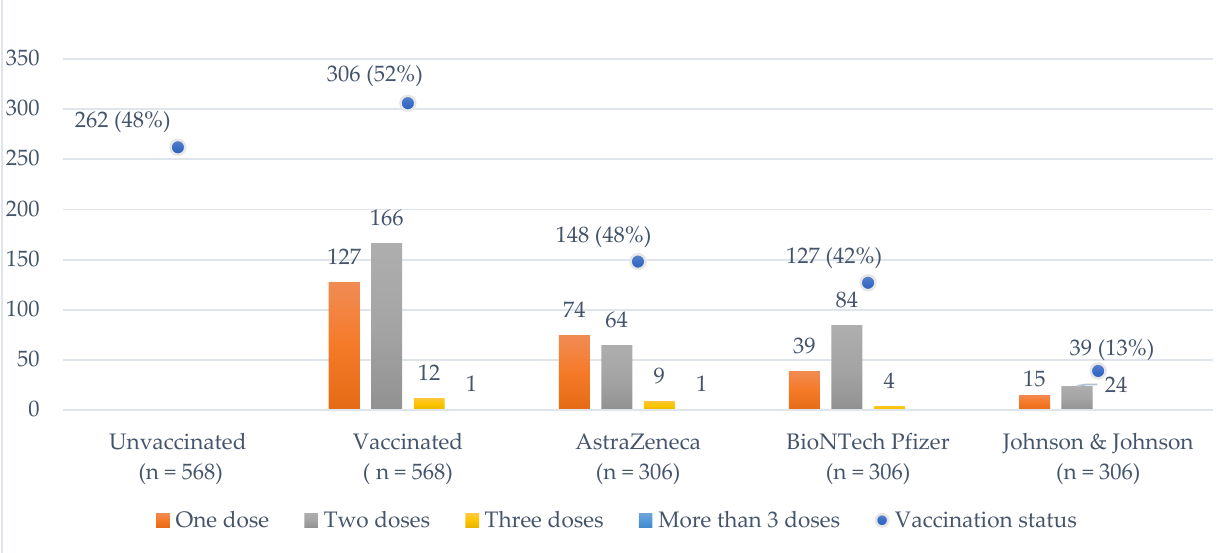
Figure 1. Reported vaccination status, type of vaccine*, and number of doses received. * Type of vaccine received is not cumulative since multiple responses are possible due to mixing (e.g., an individual receiving two doses may have been administered AstraZeneca and Johnson & Johnson).